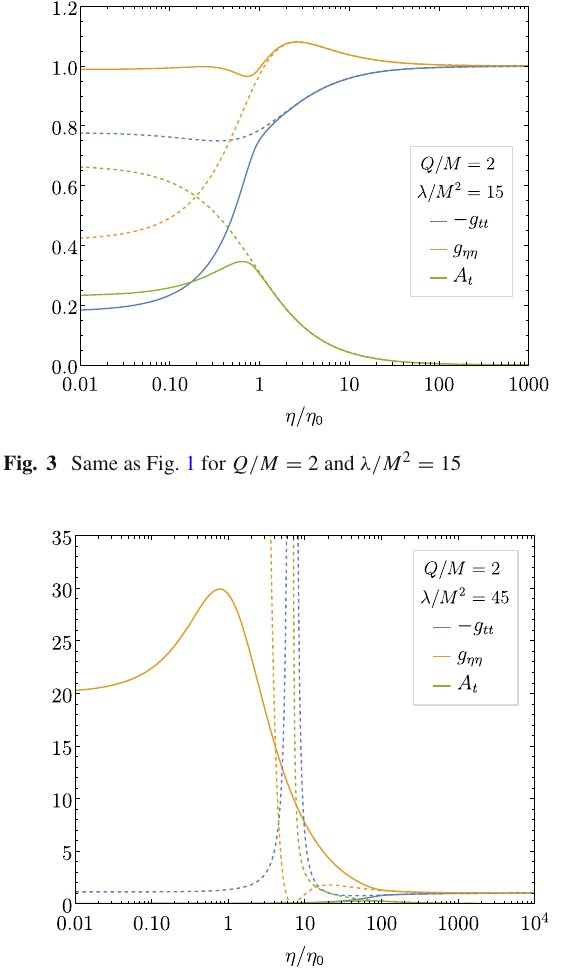
Fig. 2 Same as Fig. 1 for Q / M = 1 and λ/ M 2 = 20